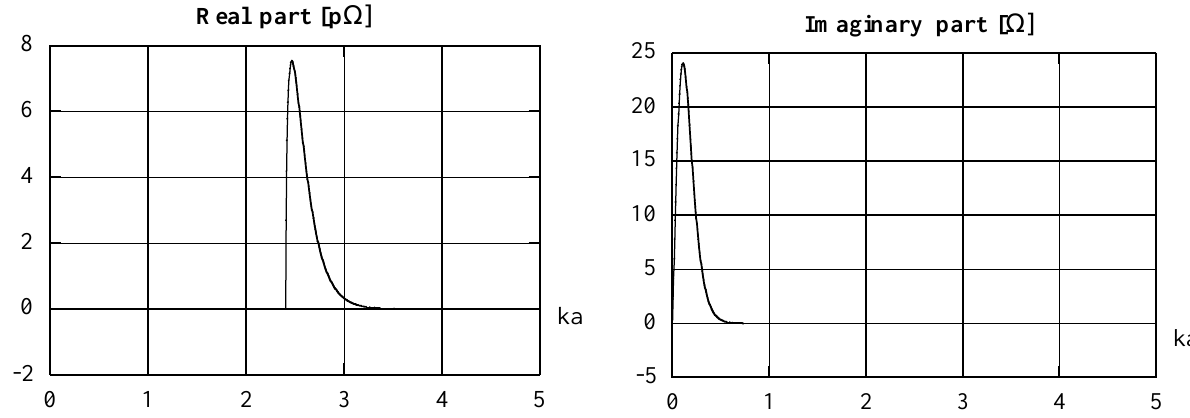
FIG. 8. Real and imaginary parts of the longitudinal coupling impedance in the case (cid:119) (cid:173) (cid:52) (cid:121) (cid:53) and bg (cid:173) (cid:49) (cid:121) (cid:49)(cid:48) .